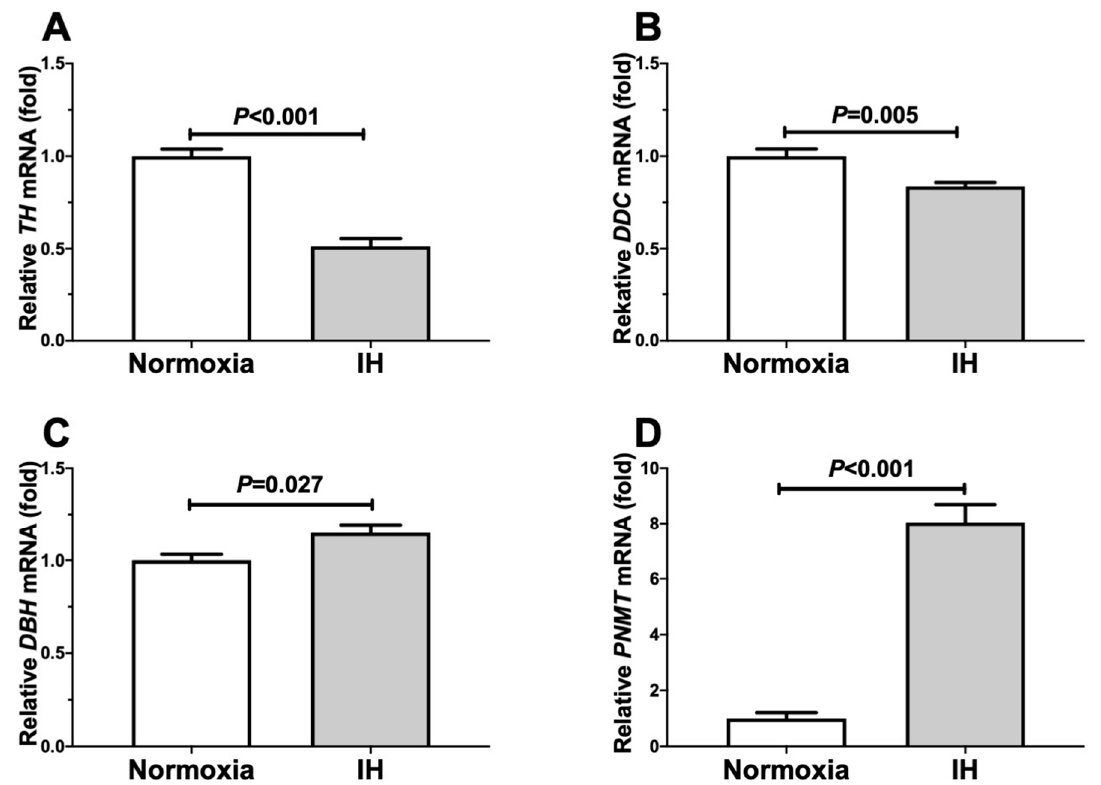
Figure 2. The mRNA levels of TH ( A ), DDC ( B ), DBH ( C ), and PNMT ( D ) in human NB-1 cells subjected to normoxia or IH for 24 h. The levels of the mRNAs were measured by means of a real-time RT-PCR using β -actin as an endogenous control. The data are expressed as the mean ± SE for each group of six independent experiments (n = 6). The statistical analyses were performed using Student’s t -test.